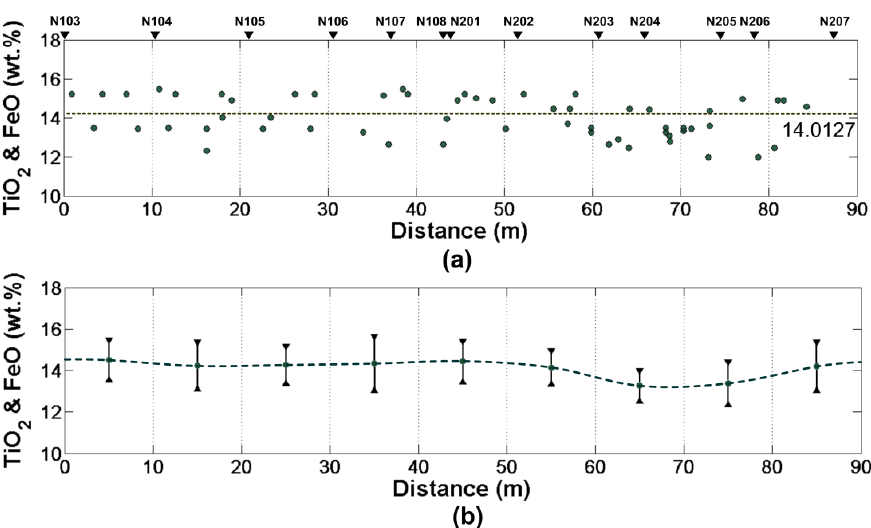
TiO and FeO and the location.( a ) Scatterplot of the content of Figure 18. Analysis of the content of 2 Figure 18. Analysis of the content of TiO 2 and FeO and the location. ( a ) Scatterplot of the content of TiO and FeO and distance. ( b ) The average content of TiO and FeO every 10 m. The error bars TiO 2 and FeO and distance. ( b ) The average content of TiO 2 and FeO every 10 m. The error bars show 2 2 show the standard deviation. the standard